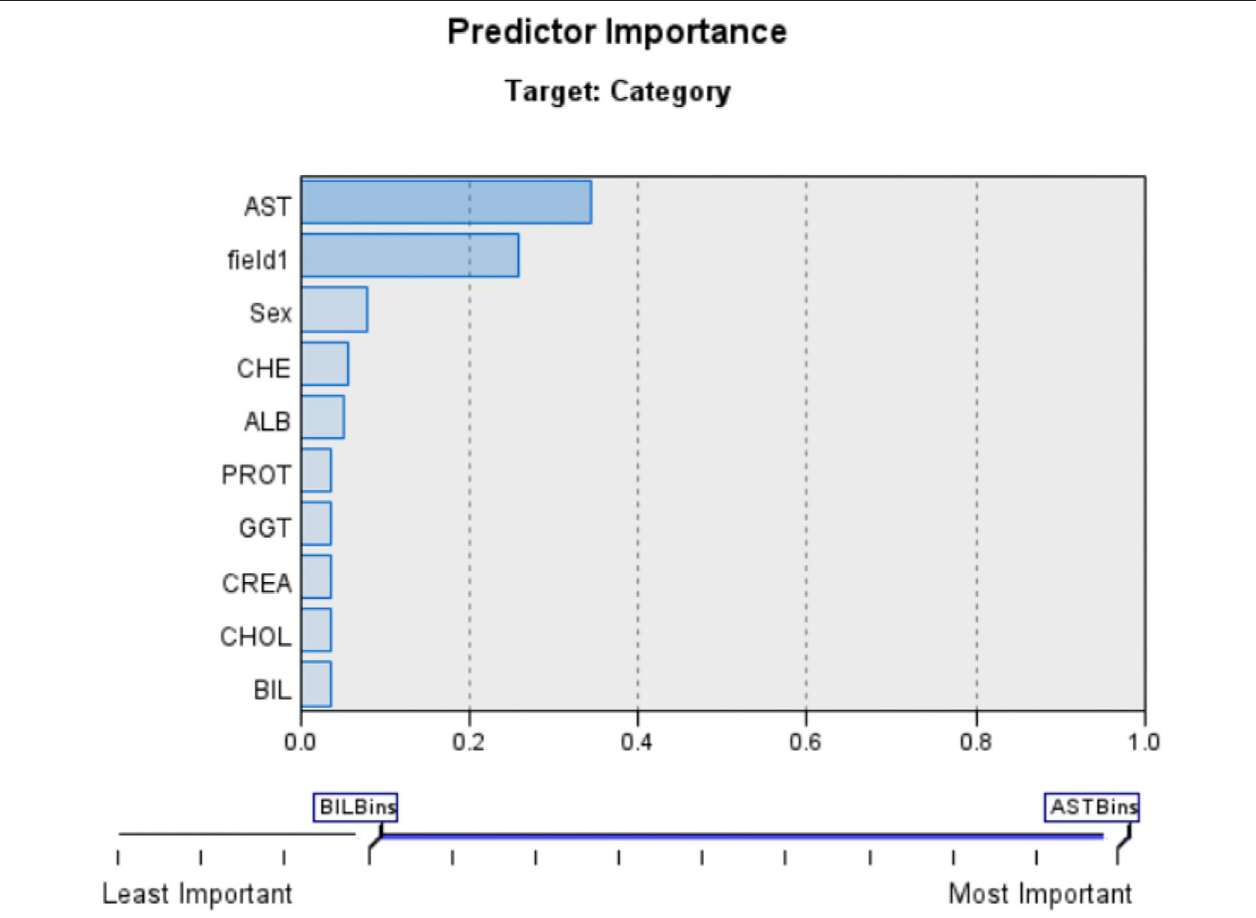
FIGURE 5 | Bayesian network